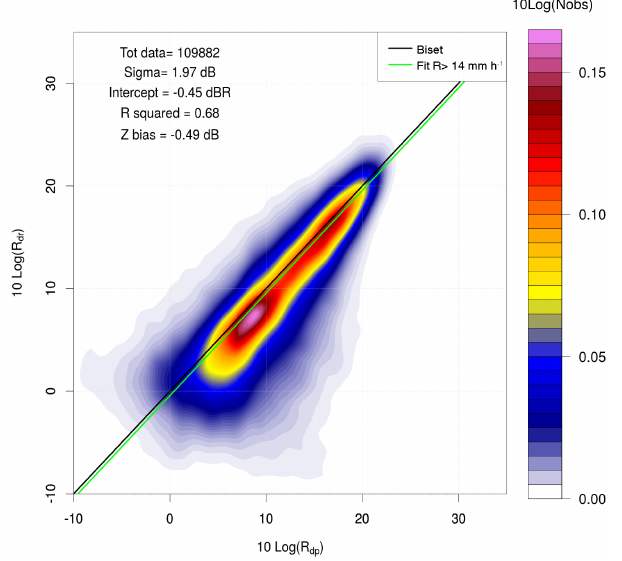
Figure 10. As in Fig. 6 but for the Monte Settepani radar, 13 Octo- ber